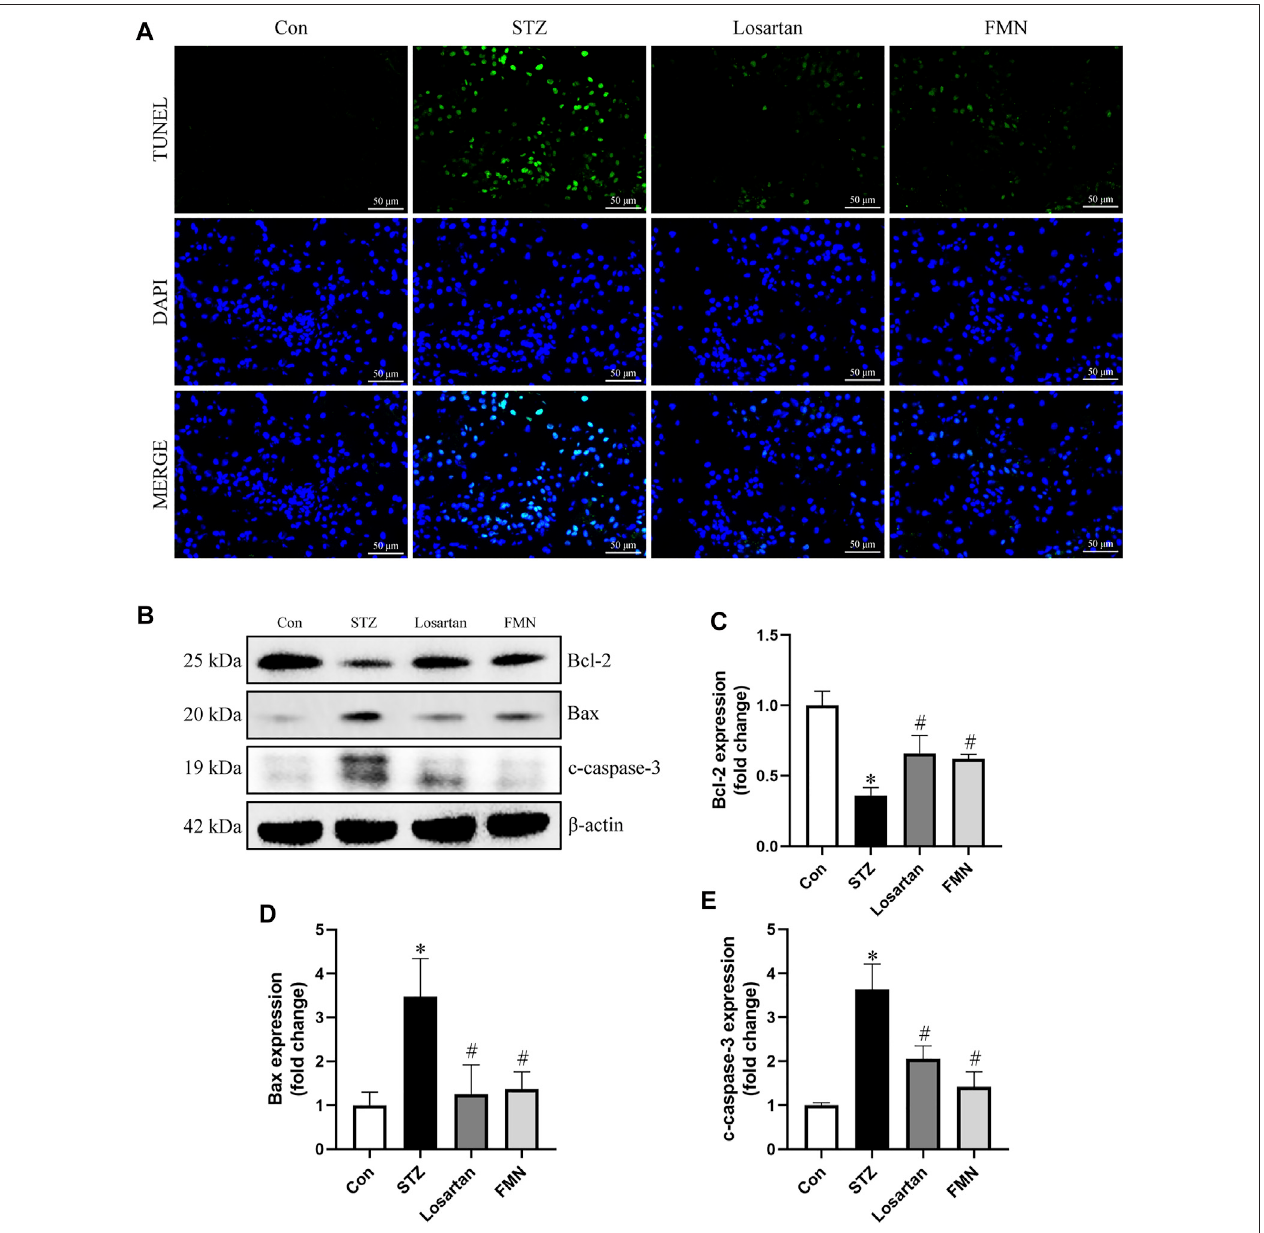
FIGURE3| FMNattenuatedrenaltubularcellsapoptosis indiabetic rats. (A) Representativedouble immuno fl uorescence labeling,including theTUNELassayand DAPI on frozen kidney sections (B – E) Representative images of Bcl-2, Bax and c-caspase-3 protein expression and semiquantitative analyses in different groups. Results were expressed as mean ± SD. * p < 0.05 vs. normal control rats. # p < 0.05 vs. STZ-induced diabetic rats.